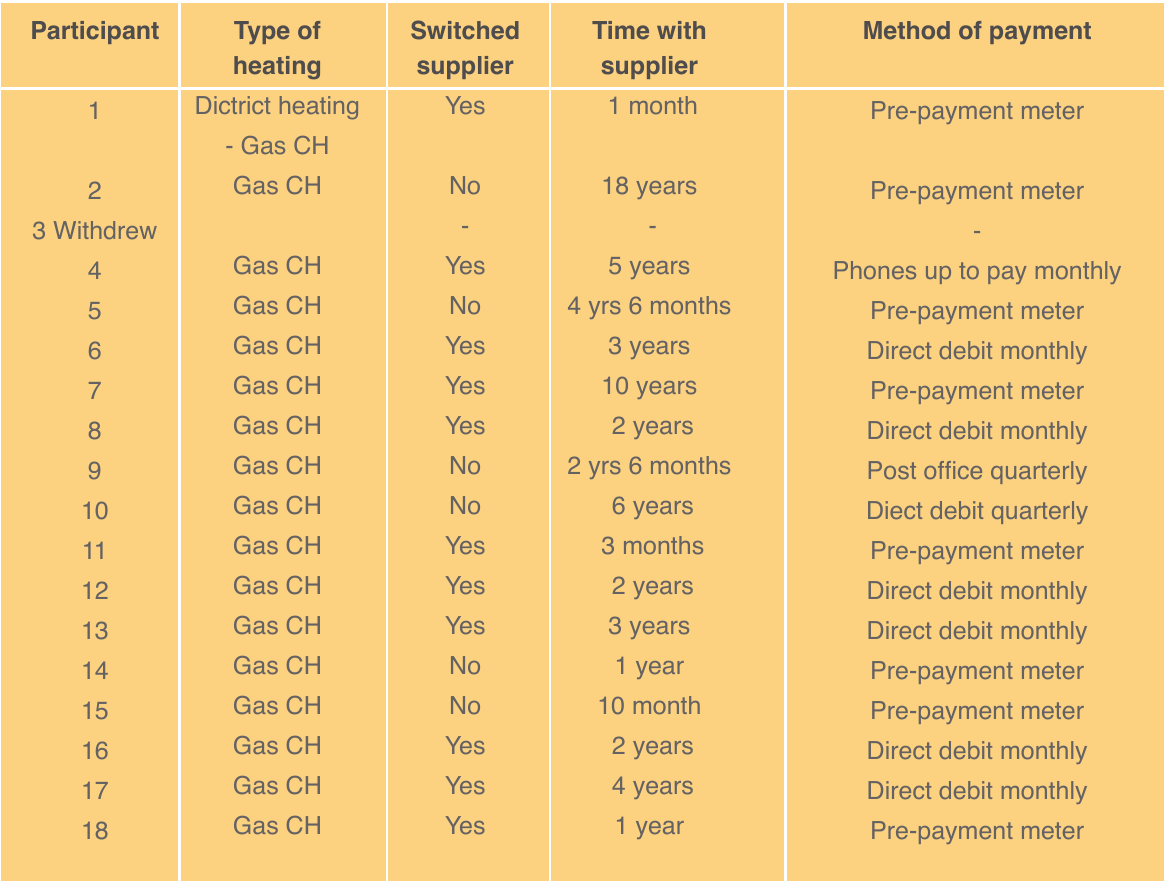
Table 2. Characteristics of parents interviewed: Heating